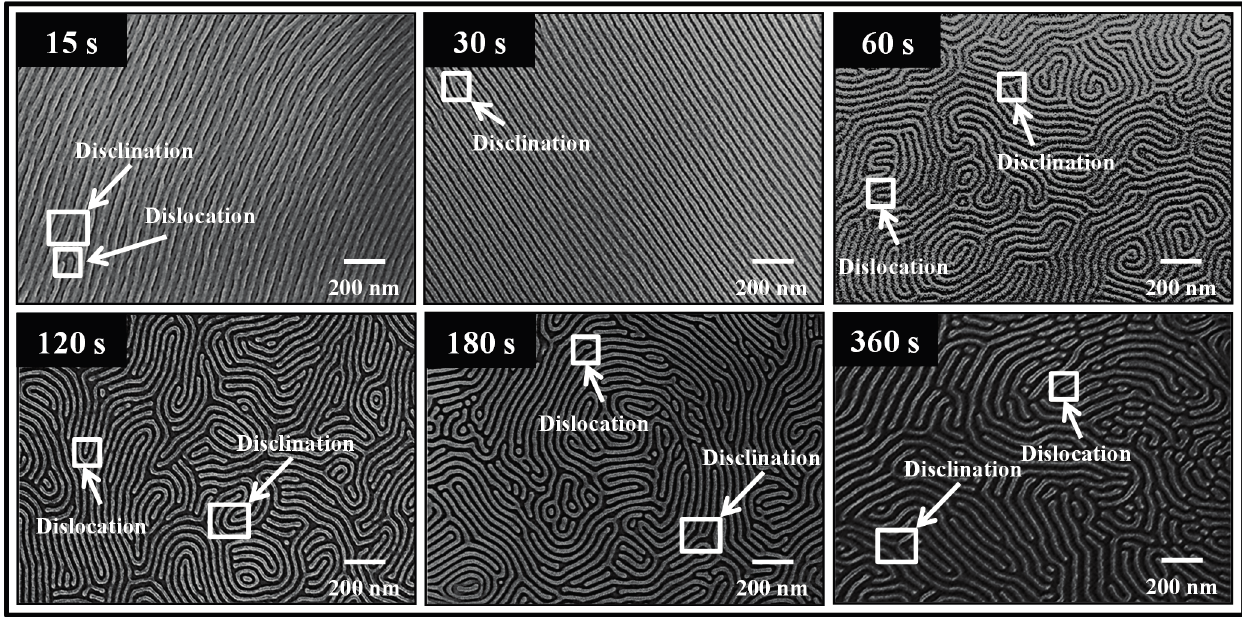
Figure 2. Top-down SEM images of the PS- b -PDMS pattern formed via microwave annealing in the presence of toluene at a target temperature of 50 °C for different time periods as labelled on the